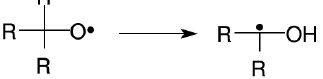
Table 3. Initial box-model (CAABA) mixing ratios and emission rates for selected gas-phase species. Initial mixing ratios are a mod- ified version of the scenario used by Taraborrelli et al.